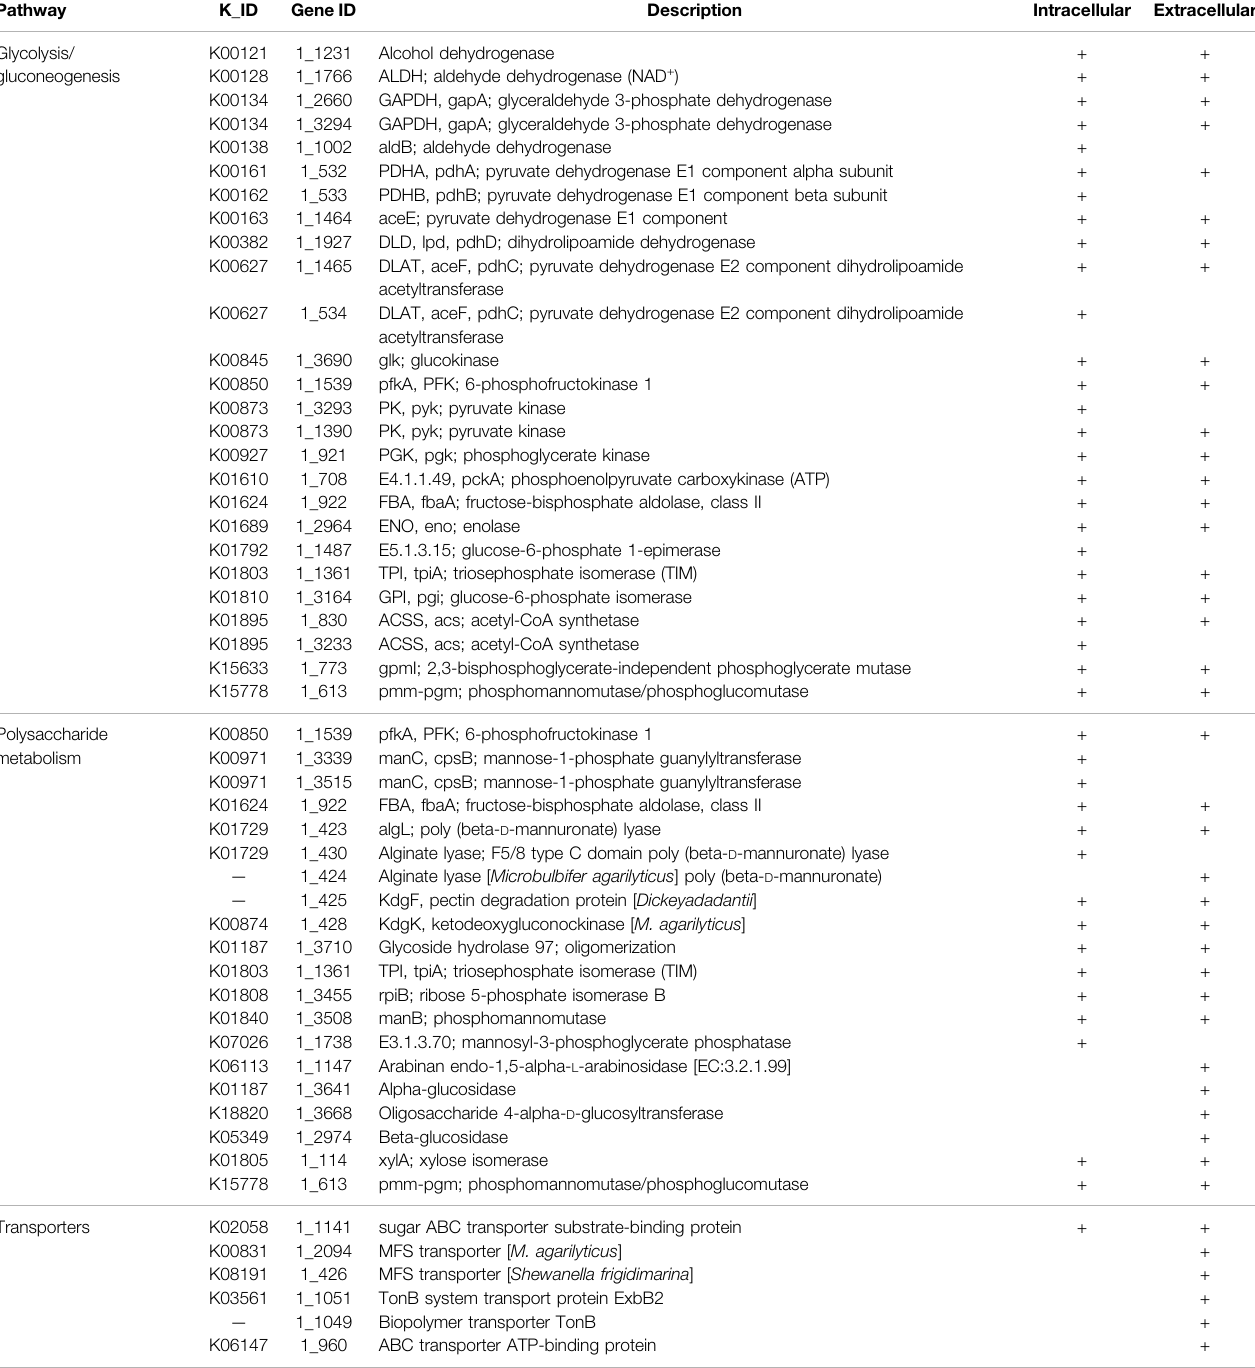
TABLE 1 | Proteins about the polysaccharide metabolism by strain ALW1.